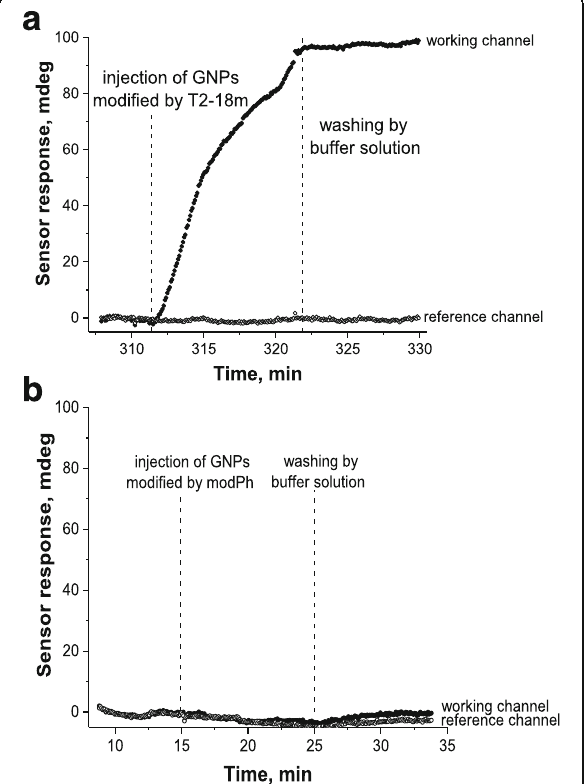
Fig. 3 The SPR sensorgrams, which demonstrate the SPR DNA hybridization sensor response on the injections of 0.5 nM GNPs modified by the complementary oligonucleotides T2-18m ( a ) and 0.5 nM GNPs modified by the non-complementary oligonucleo- tides mod-Ph ( b ). Reference channel was washed by the running buffer solution